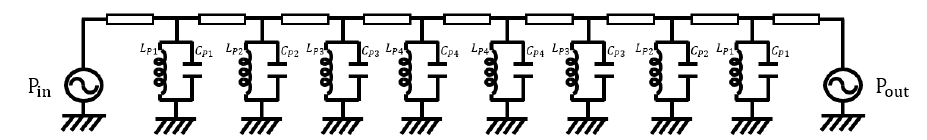
Figure 1. Equivalent circuit network of the bandpass filter.